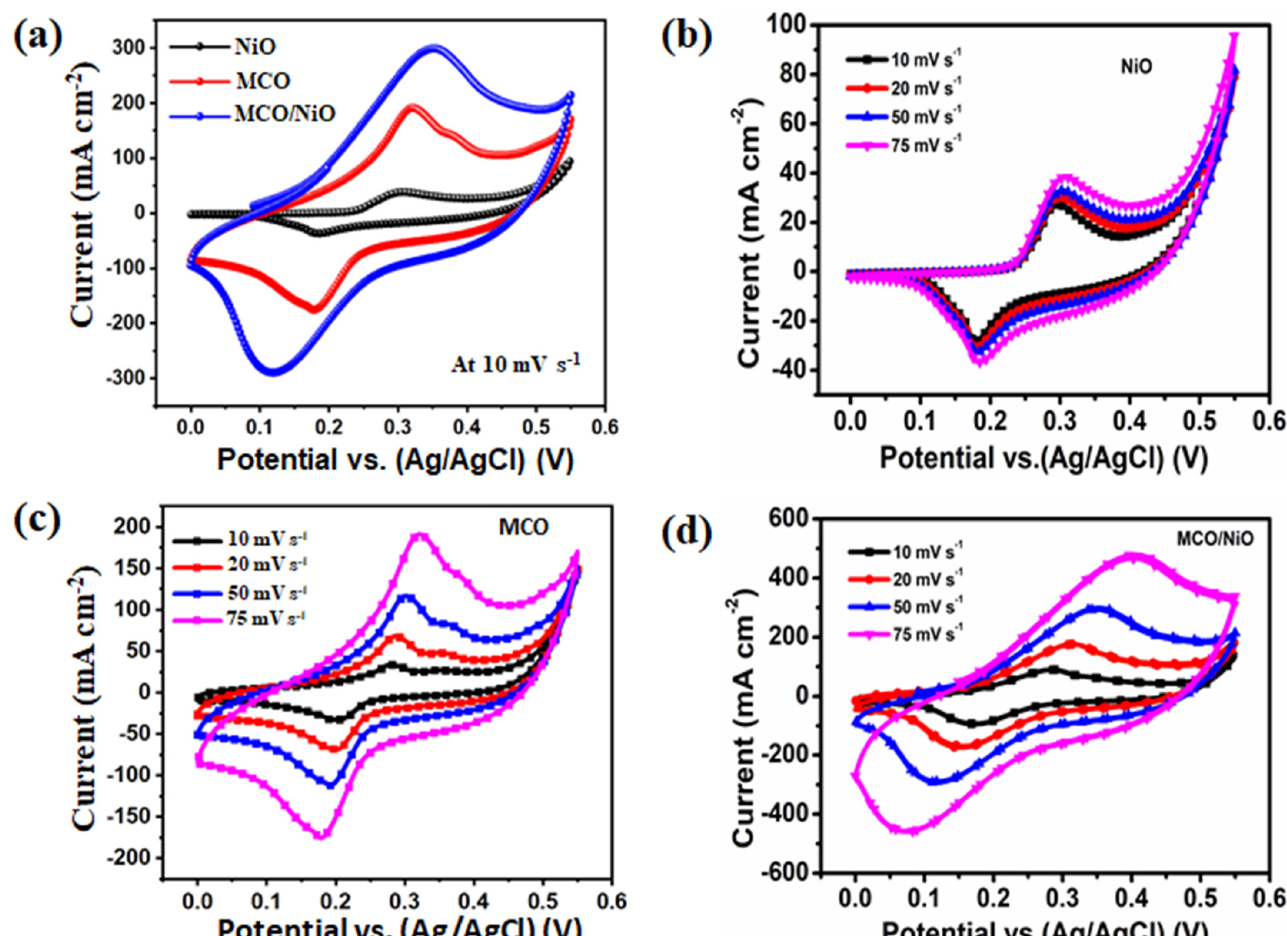
Figure 4. ( a ) Comparison of CV curves of MCO, NiO, and MCO/NiO electrodes at a scan rate of 10 mV s − 1 , CV curves of the ( b ) NiO, ( c ) MCO, and ( d ) MCO/NiO electrodes at various scan rates.